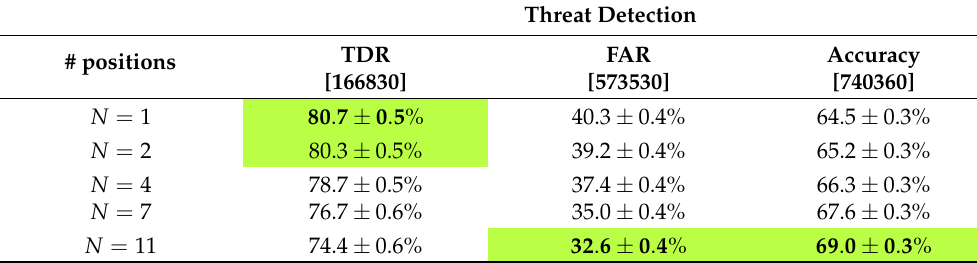
Table 4. Results for the threat detection mode by varying the number of positions used in the GMM training with the best result for each metric in bold font. ‘TDR’ stands for threat detection rate and ‘FAR’ for false alarm rate. Confidence intervals are shown for a 95% confidence. Green cells show values within the confidence interval for the best performance value (i.e., statistically non- significant differences). The values shown between brackets denote the number of frames that belong to the corresponding class, where the number below FAR represents the number of non-threats in the database.